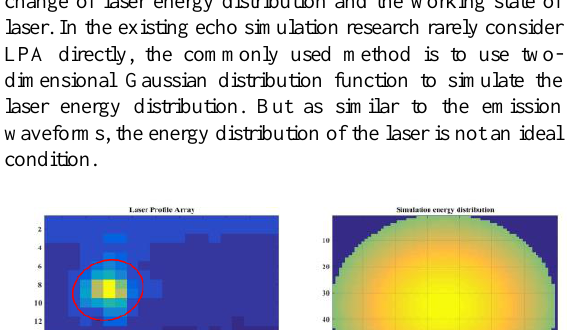
Table 4. Effect of Reflectance on Simulation Results